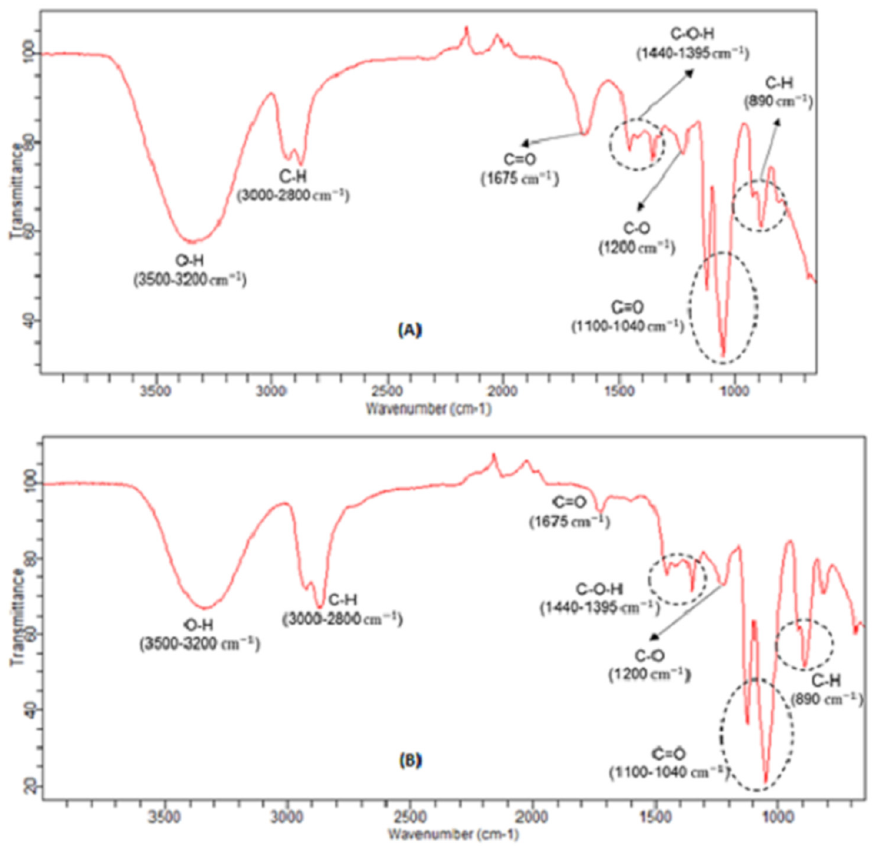
Figure 9. FTIR spectra: ( A ) corresponding to the initial sample of liquefied biomass, prior to any test; ( B ) corresponding to the biomass sample after the test at 250 ◦ C, without catalyst.